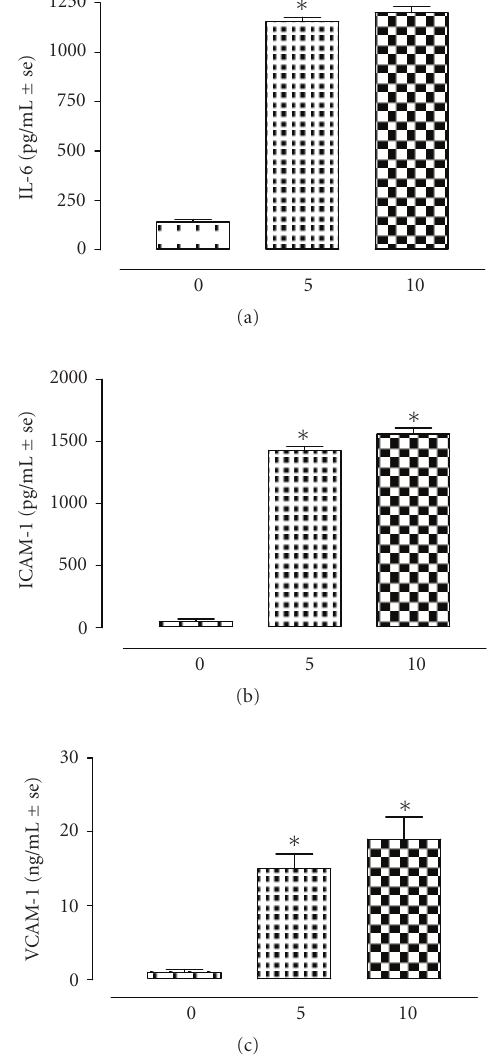
Figure 4: Levels of IL-6, VCAM-1, and ICAM-1 within the peri- toneal lavage fluid of rats ( n = 8) during the development of peri- toneal adhesions. The time is expressed in days. Di ff erence versus time 0 is represented as ∗ P < .